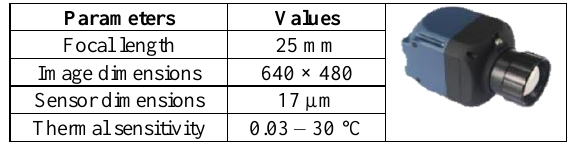
Table 2. Technical specifications of the thermal infrared camera.